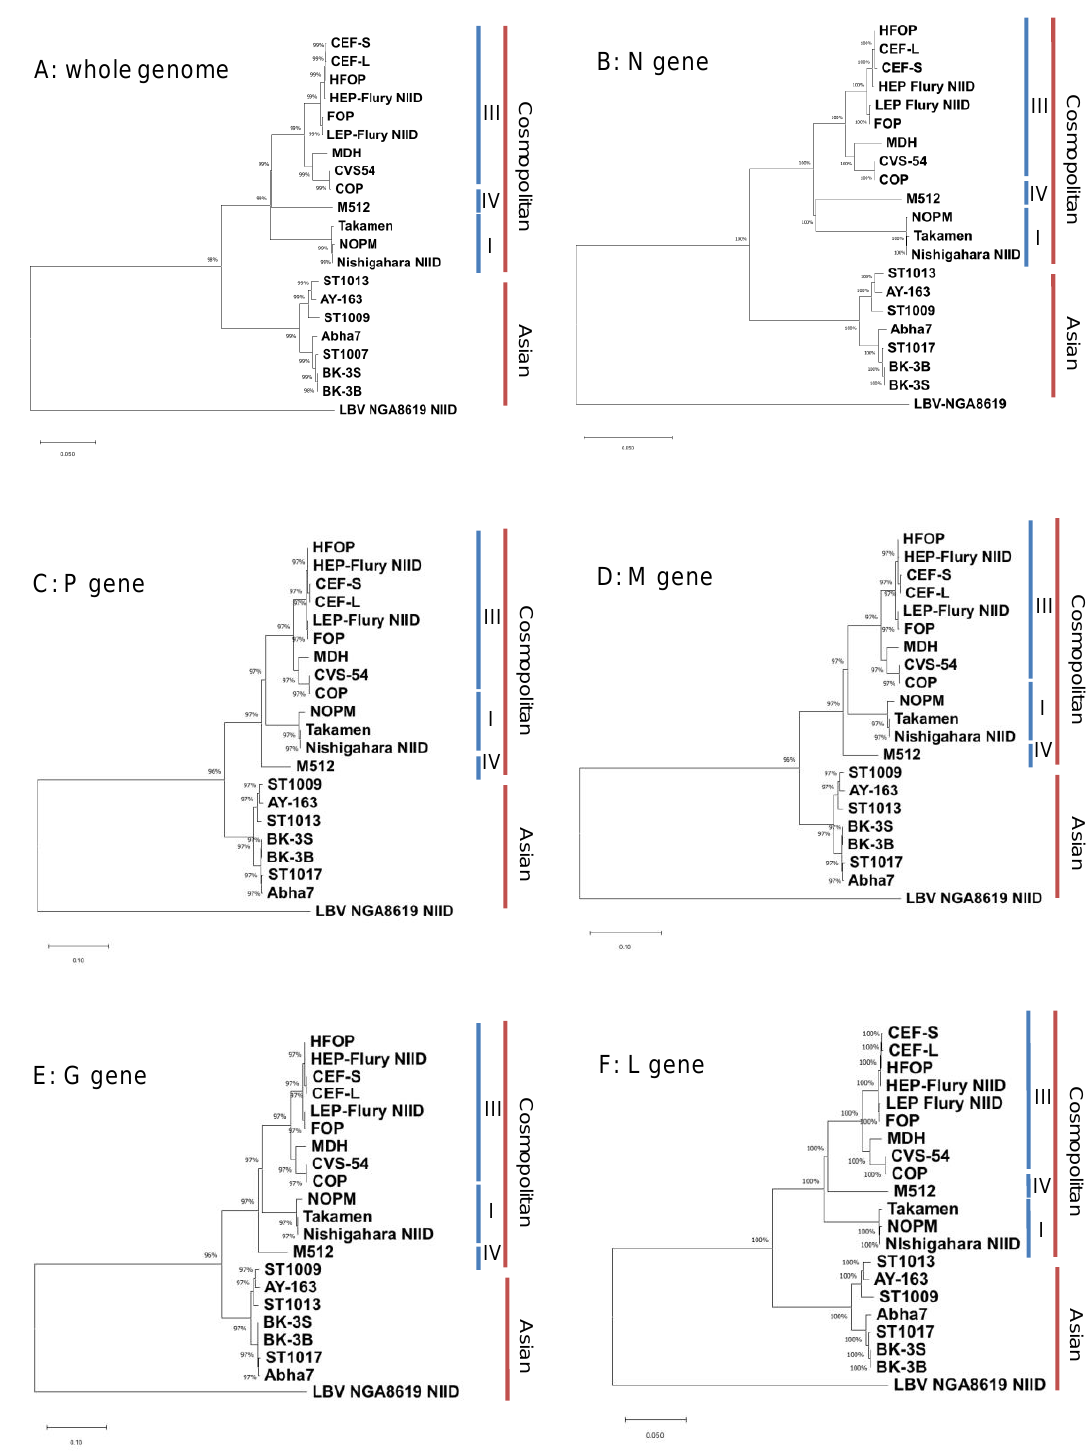
Figure 2. Phylogenetic analysis of the rabies strains sequenced in this study. Phylogenetic analysis of the rabies strains sequenced in this study was performed for the whole-genome sequence and the N, P, M, G, and L genes using the neighbor-joining method and 1000 bootstrap analyses (Mega10.1 software). Posterior probabilities between 90 and 100% are indicated by numbers. The clades on the right side of the tree correspond to the clades shown in Figure 1. ( A ) Whole genome, ( B ) N, ( C ) P, ( D ) M, ( E ) G, and ( F ) L genes. The division was the same for each gene and for the whole